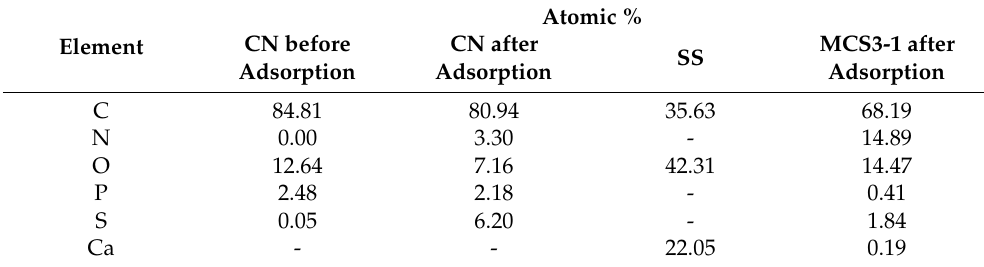
Table 1. Elemental content of CN before and after adsorption, MCS3-1 after adsorption, and SS.